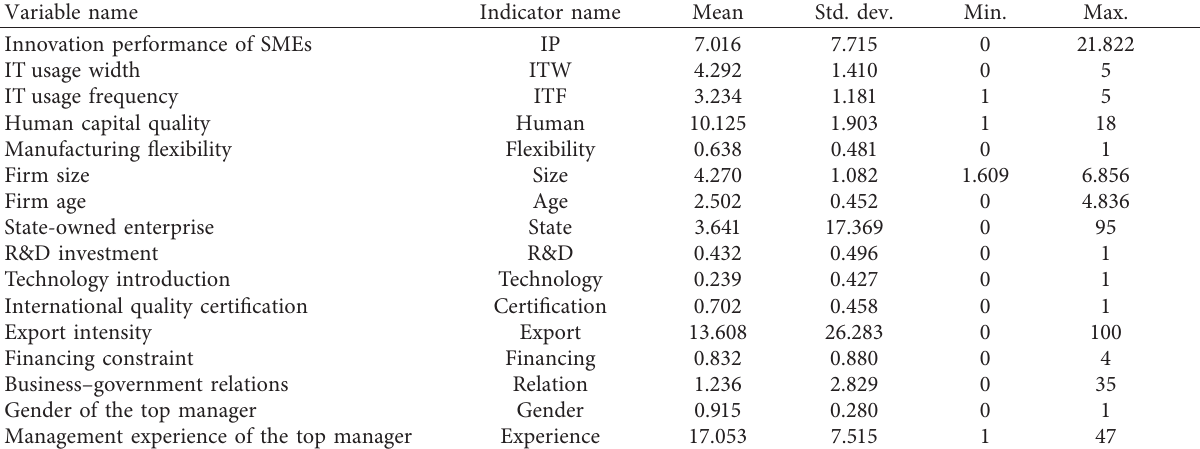
Table 1: Descriptive statistics of variables.